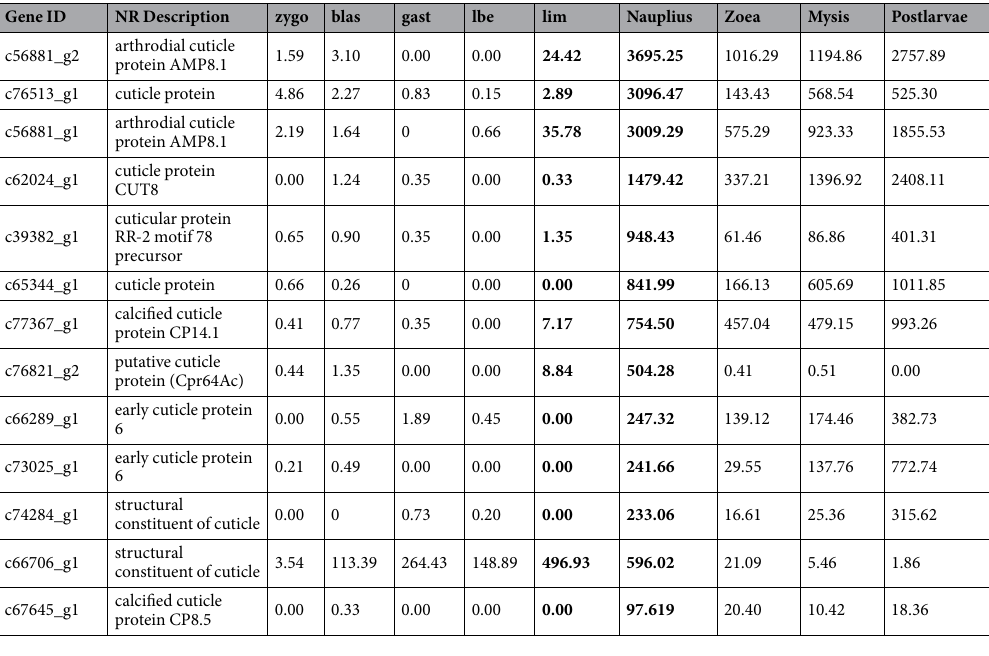
Table 4. A heatmap showing the expression profile of cuticle proteins (part) during the early development of L. vannamei . The gene ID, expression profile (FPKM value) and NR description is depicted. Bold text denotes up- regulation at phase II (larva in membrane and nauplius).